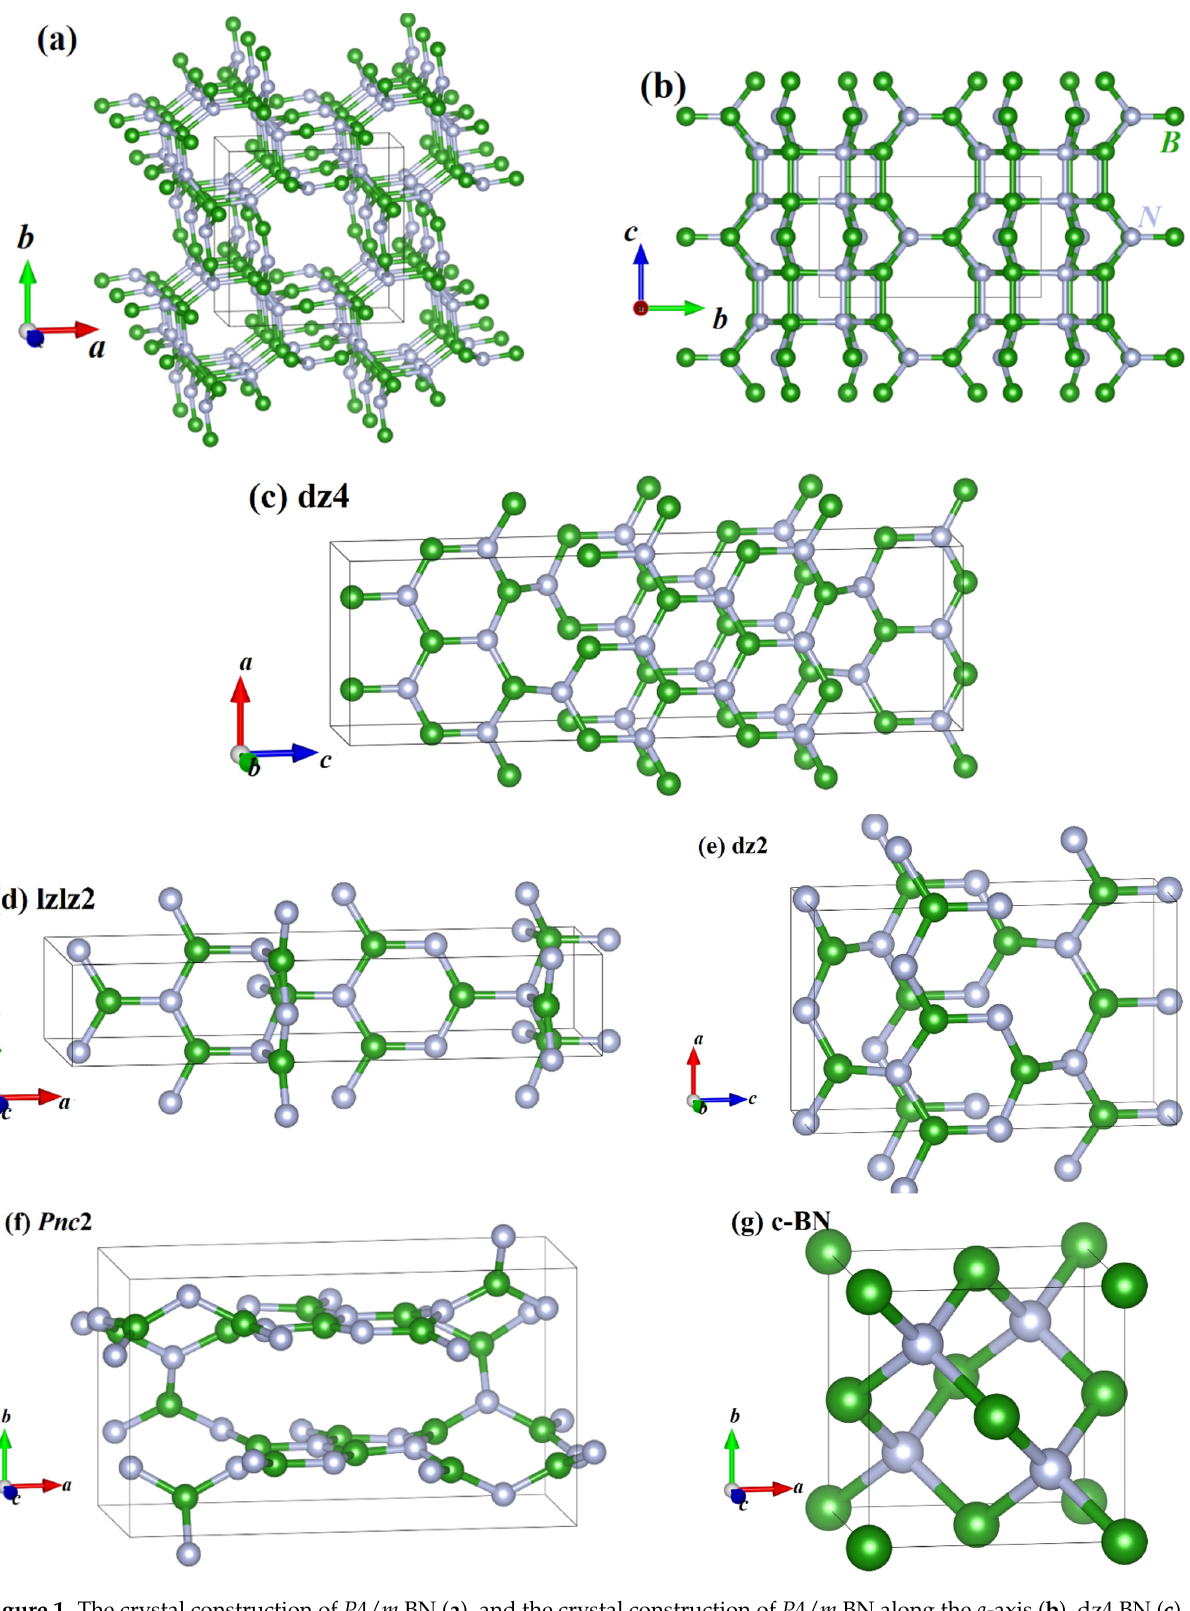
Figure 1. The crystal construction of P 4/ m BN ( a ), and the crystal construction of P 4/ m BN along the a -axis ( b ), dz4 BN ( c ), lzlz2 BN ( d ), dz2 BN ( e ), Pnc 2 BN ( f ) and c-BN ( g